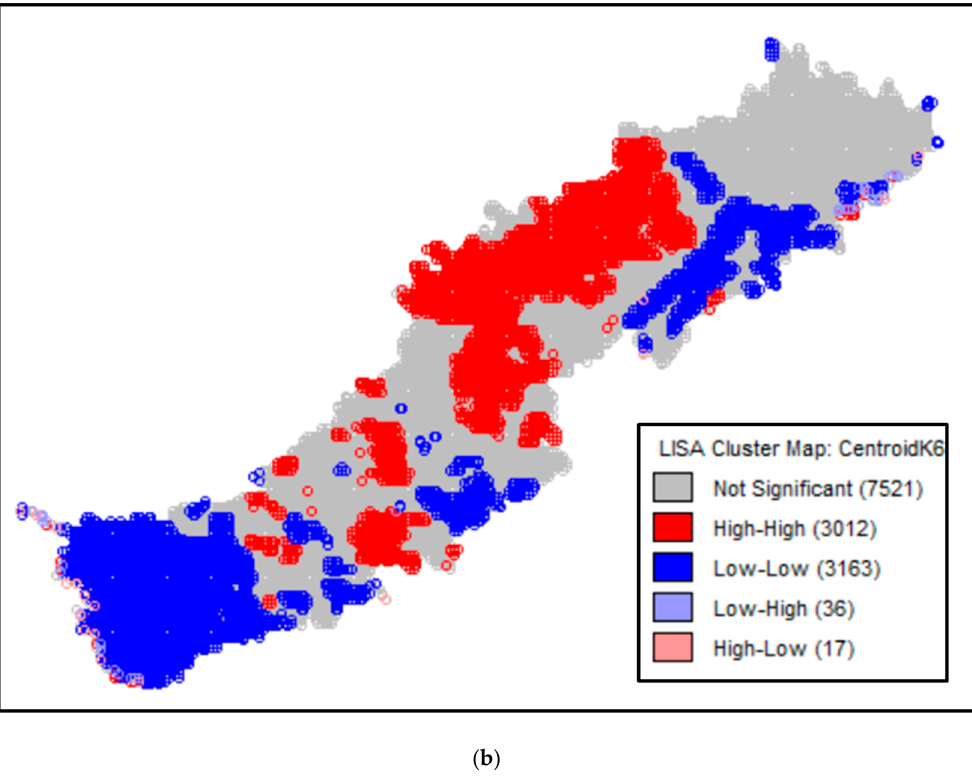
Figure 7. Autocorrelation map of frost frequency—( a ) scatter plot and ( b ) cluster map.